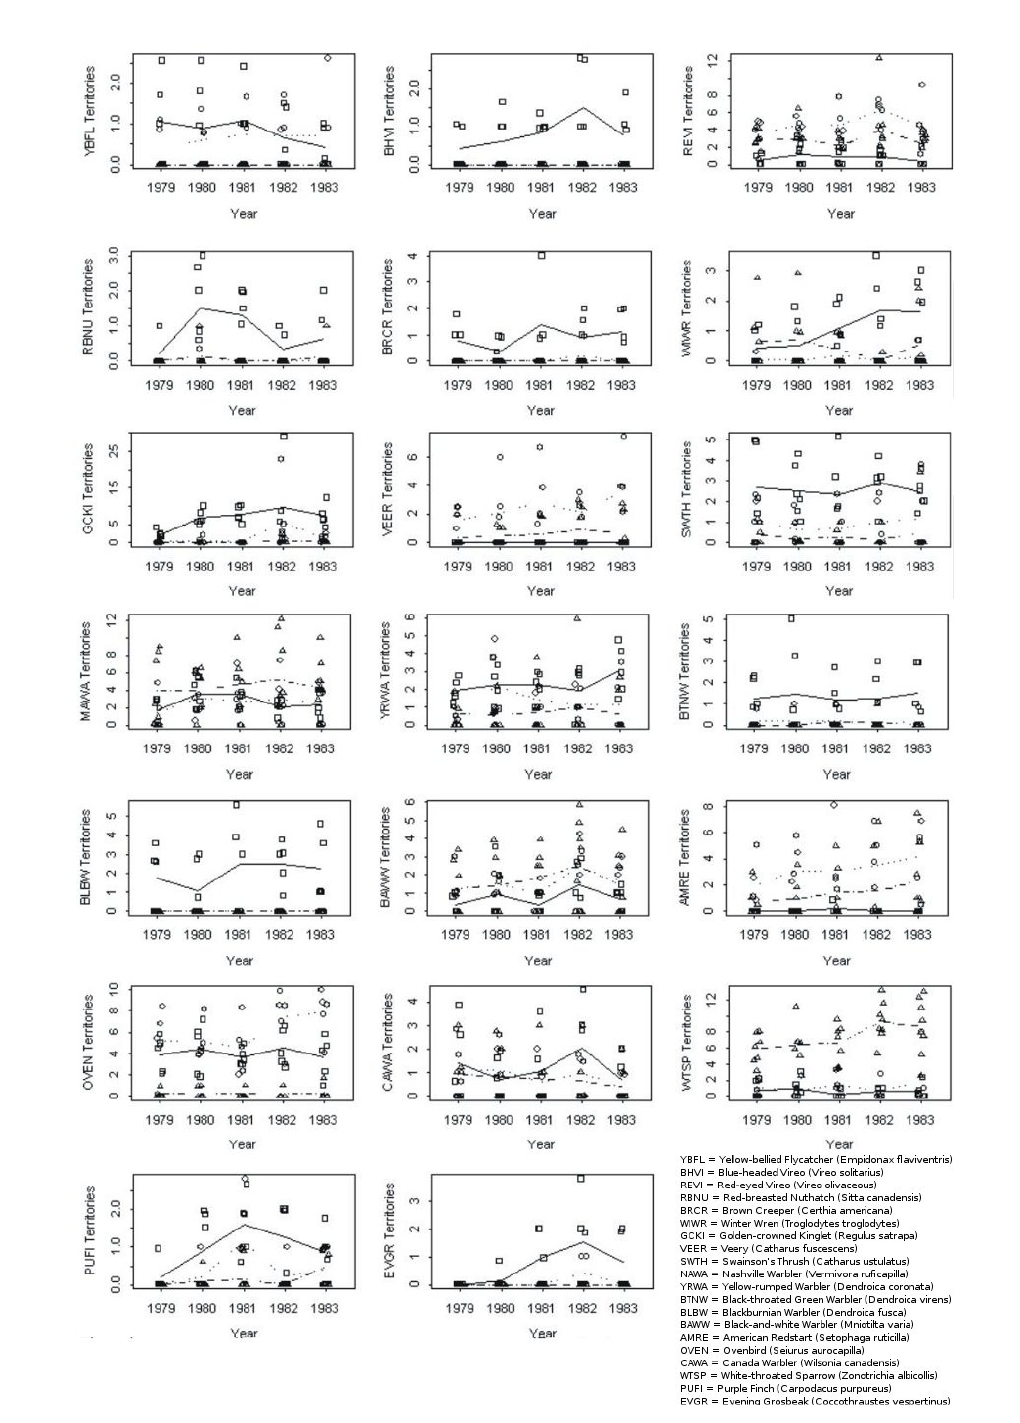
Fig. 6 . Number of territories per plot for mature plots (squares represent plots, solid line represents means), intermediate-aged plots (circles represent plots, dotted line represents means), and young plots (triangles represent plots, dashed line represents means) for 20 individual